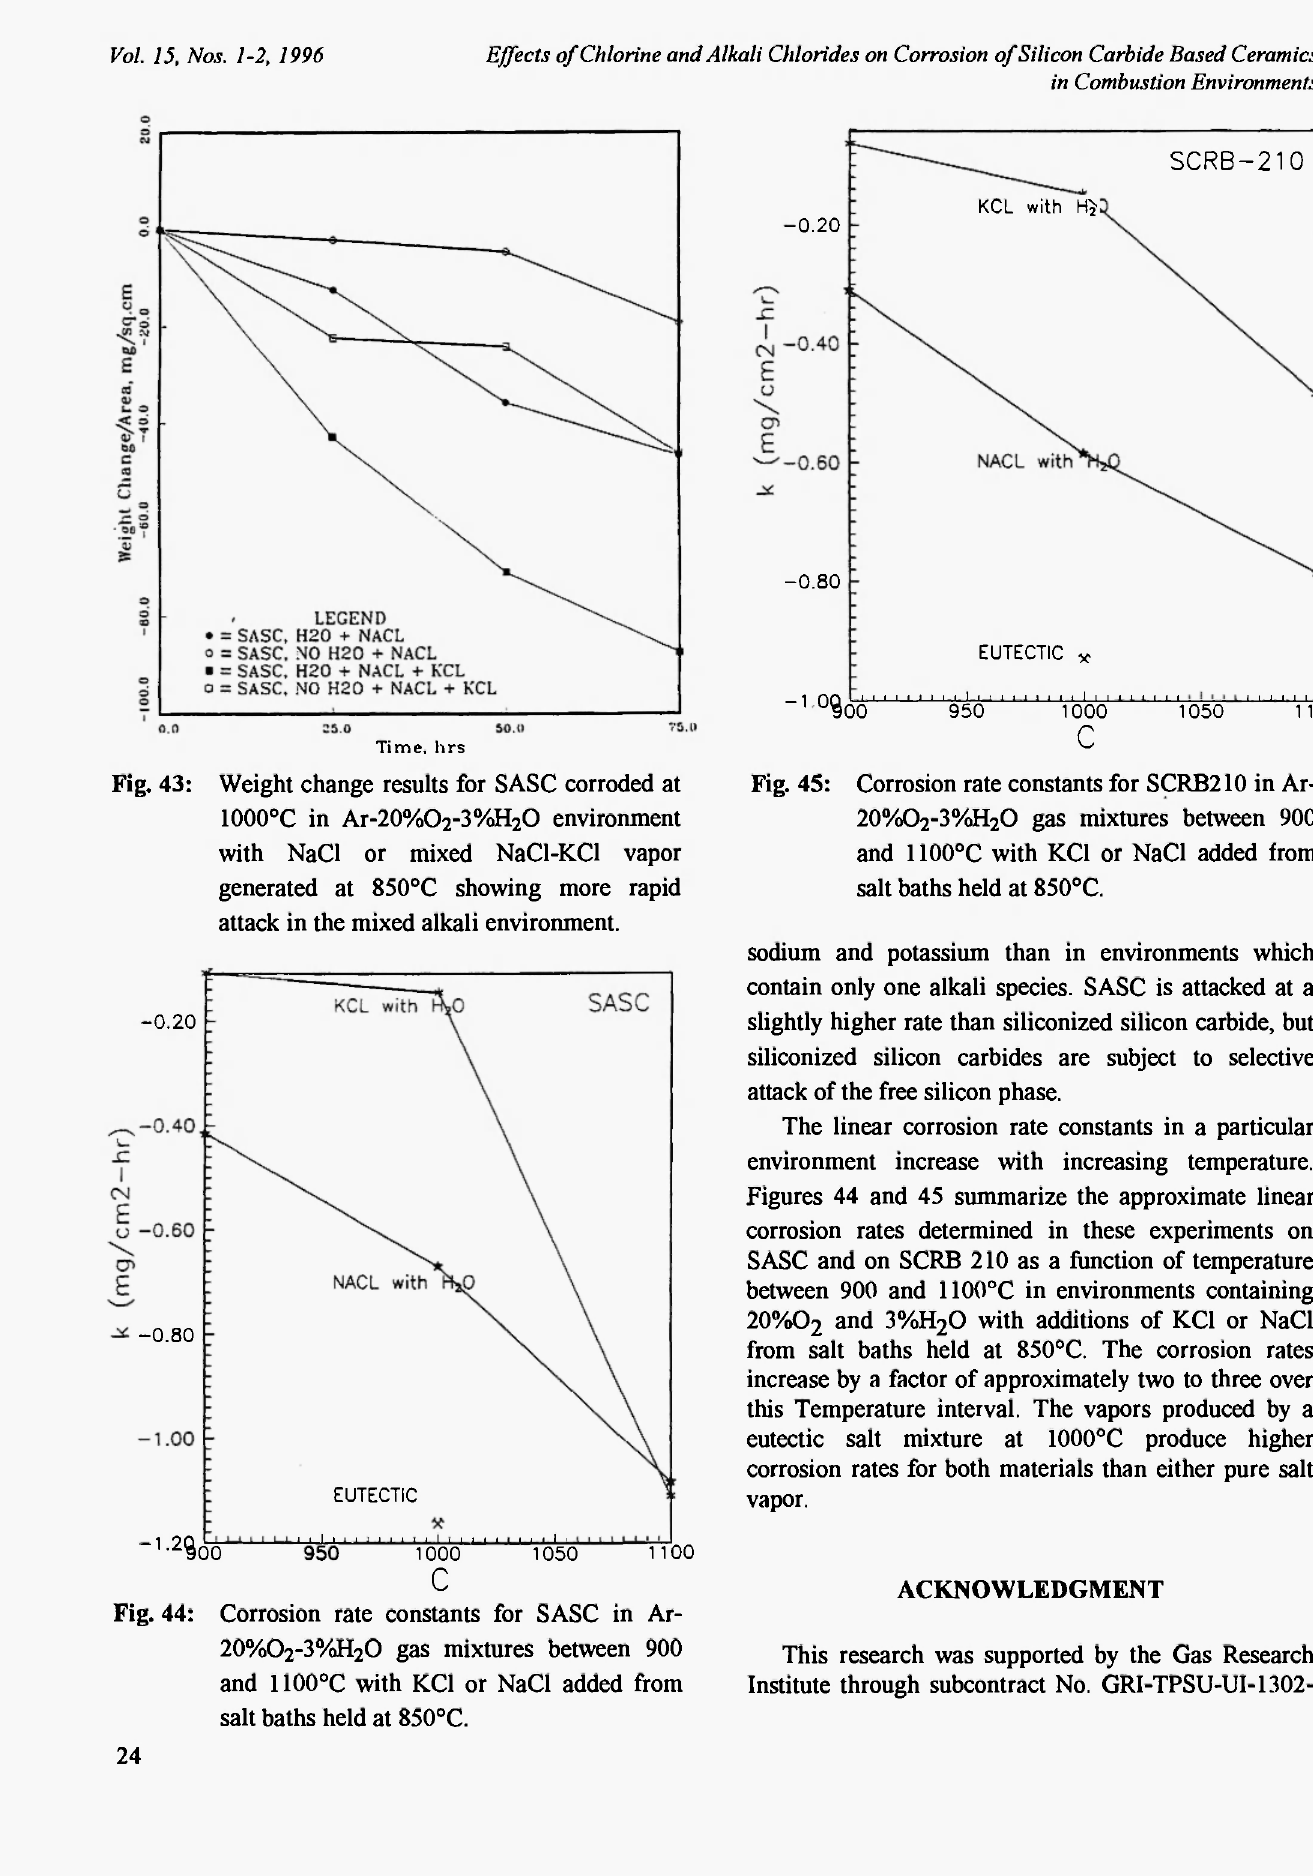
Time, hrs Fig. 43: Fig. 45: Corrosion rate constants for SCRB210 in Ar- Weight change results for SASC corroded at 1000°C in Ar-20%0 2 -3%H 2 0 environment 20%0 2 -3%H 2 0 gas mixtures between 900 with NaCl or mixed NaCl-KCl vapor and 1100°C with KCl or NaCl added from generated at 850°C showing more rapid salt baths held at attack in the mixed alkali environment.